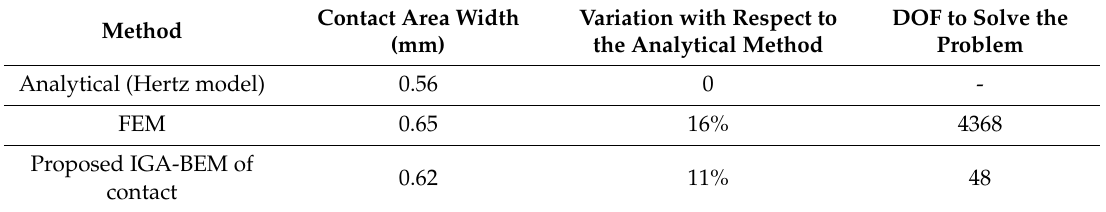
Table 9. Comparison of contact area